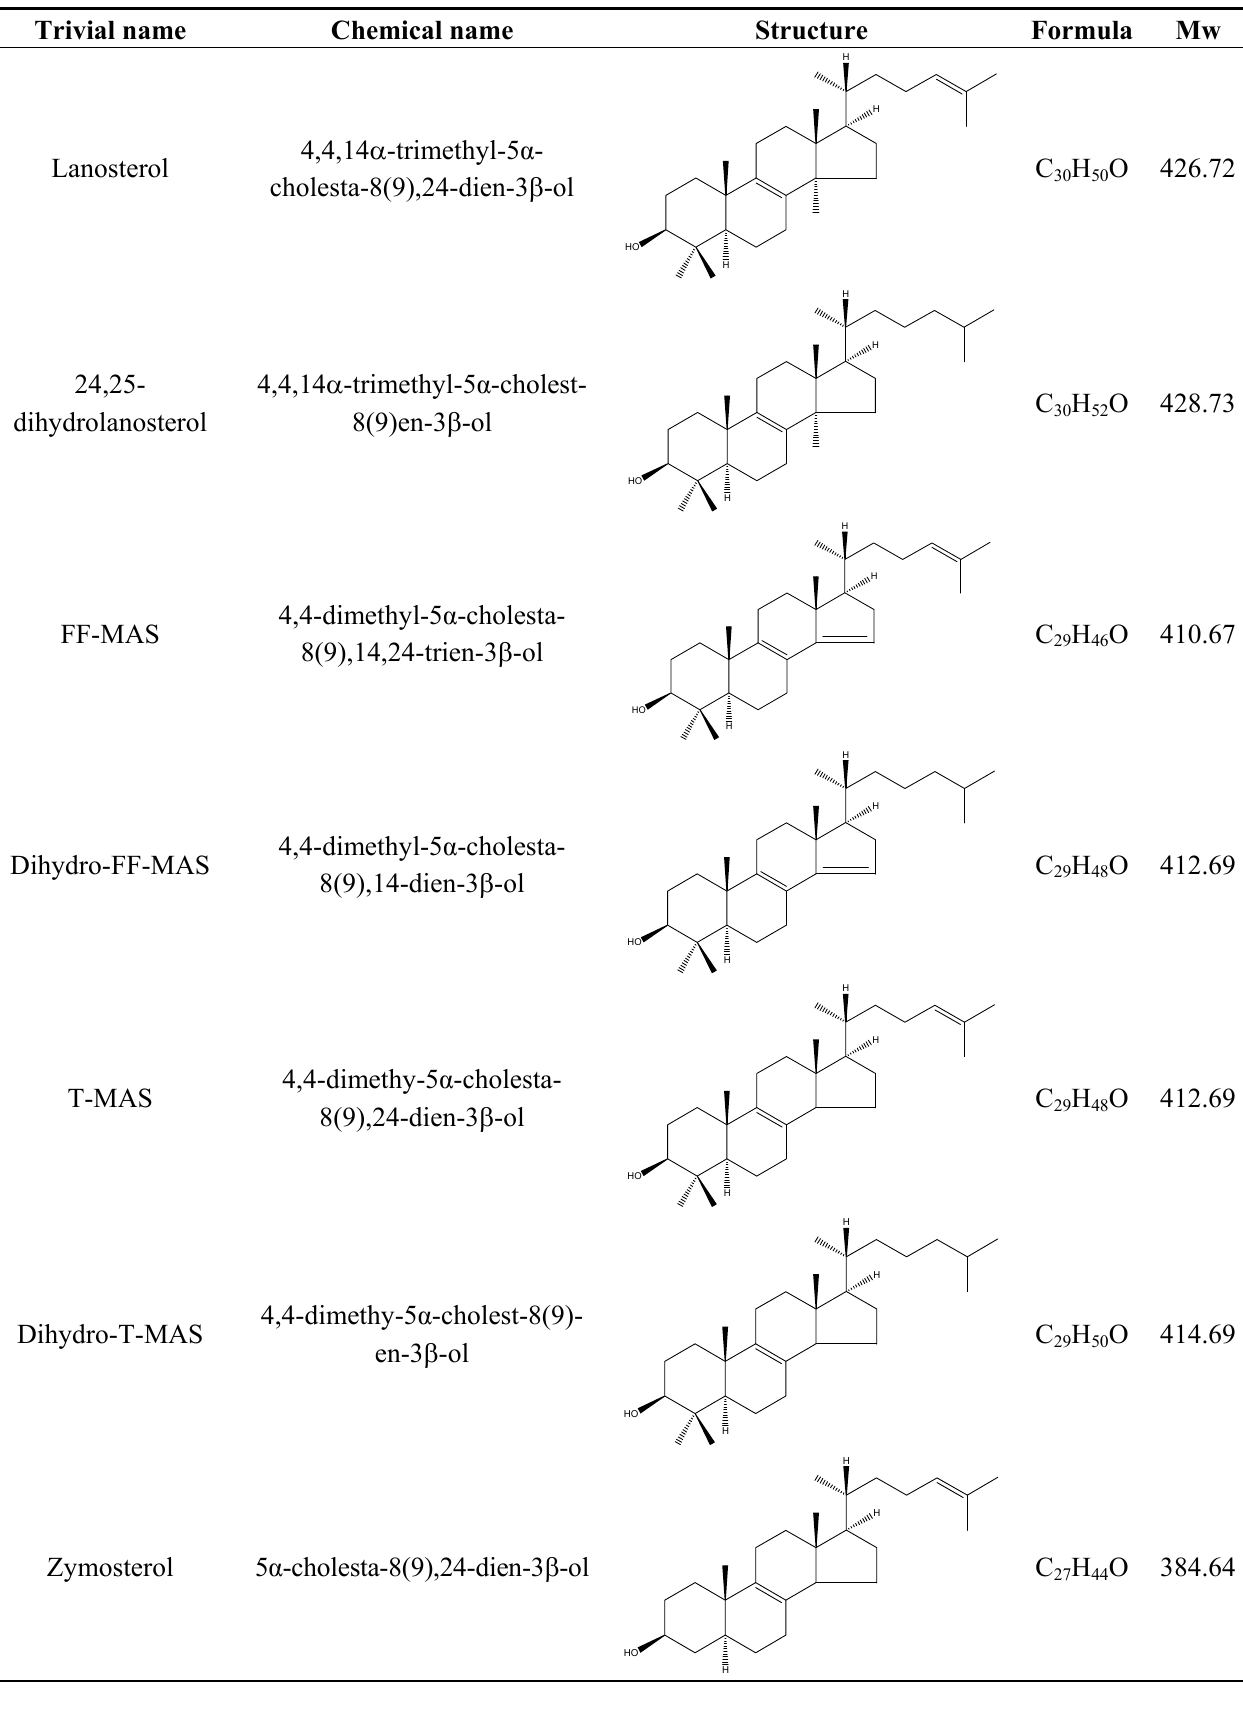
Table 2. Sterols of the post-squalene cholesterol synthesis: trivial and chemical names, structures, formulas and molecular weights